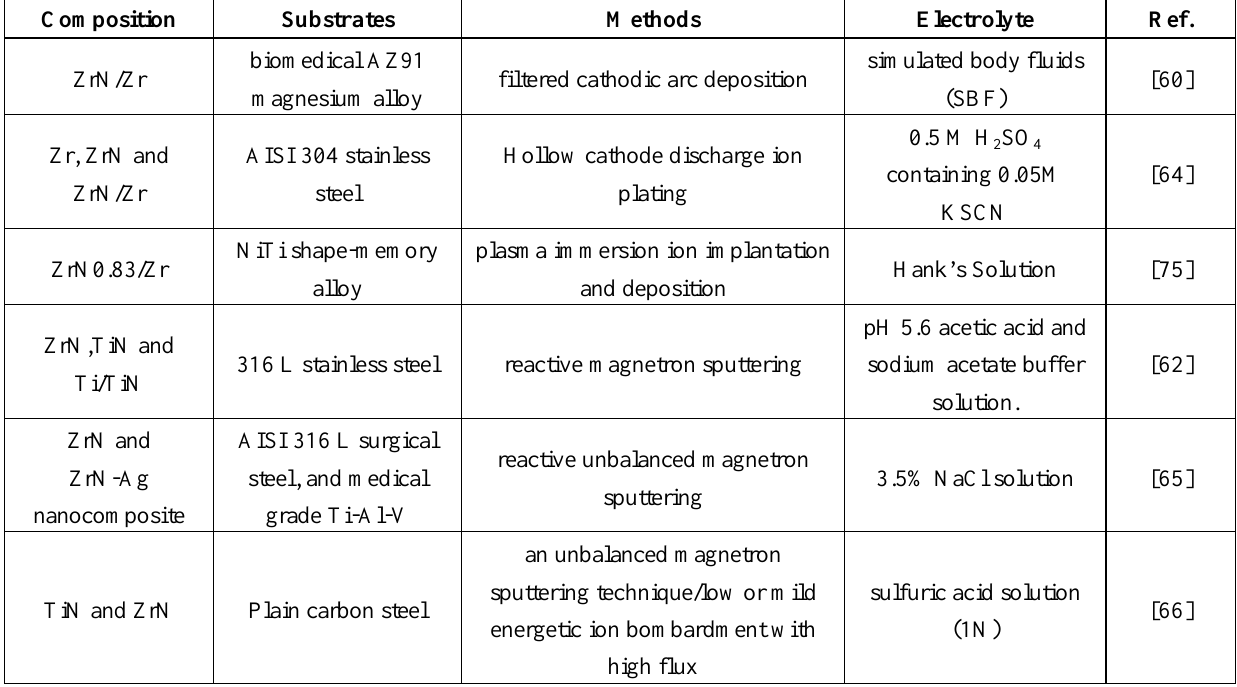
Table 1. Summary of the anti-corrosion ZrN